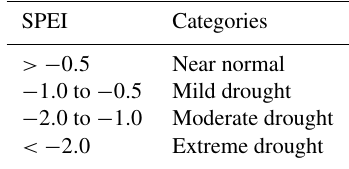
Figure 12. Projected changes in drought risks for eight typical drought-prone countries under the 2.0 ◦ C warming target. Table 2. Drought categories in the